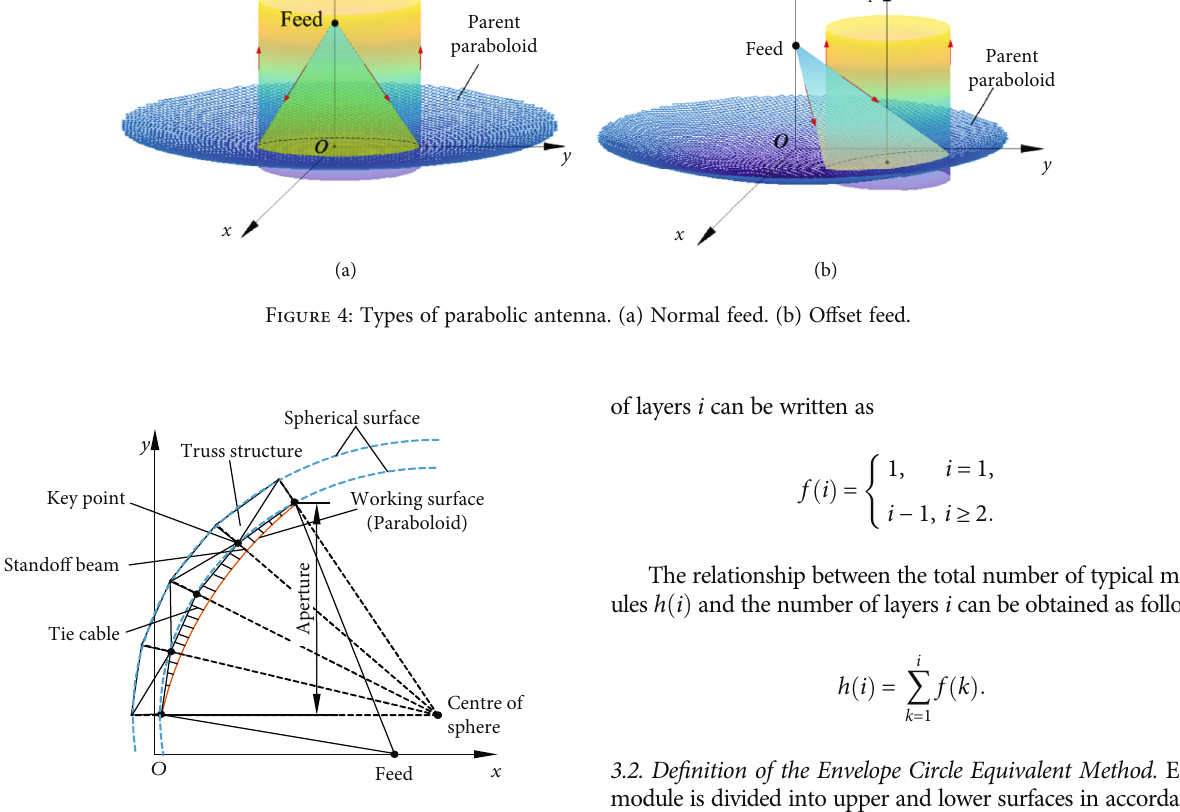
Figure 5: Relationship between the truss structure and the working